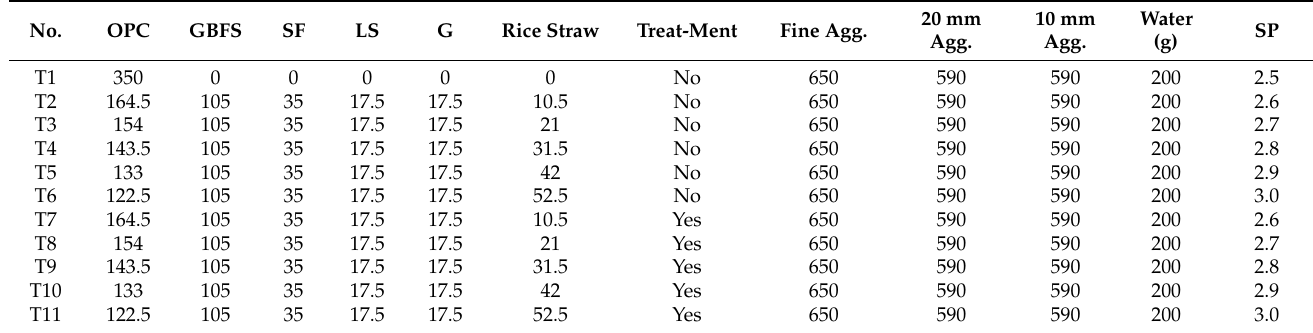
Table 3. Recipes of concrete